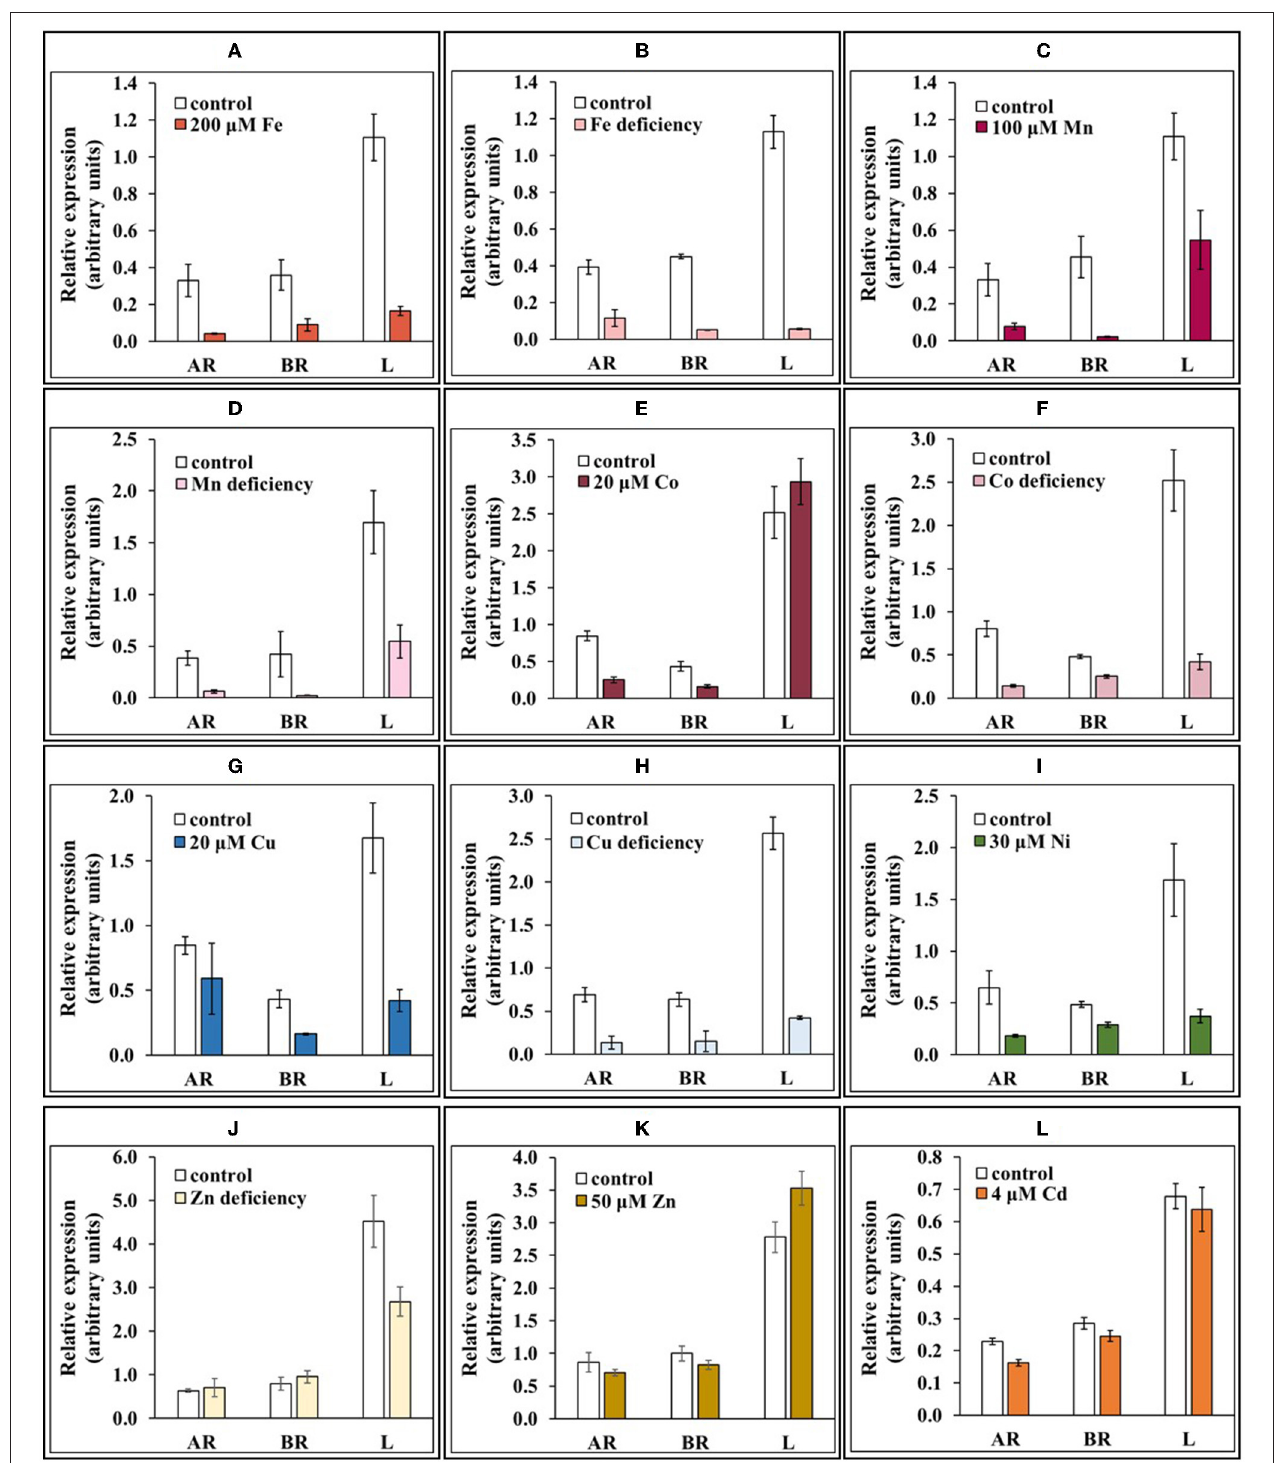
FIGURE 6 | Expression of NtNRAMP3 under different metal regimes. (A–I,L) Wild-type (WT) tobacco plants were grown at control conditions ( ¼ Knop’s medium) for 5 weeks and then were subjected to the different metal regimes for the next 4 days: (A) 200 µ M Fe; (B) Fe deficiency; (C) 100 µ M Mn; (D) Mn deficiency; (E) 20 µ M Co; (F) Co deficiency; (G) 20 µ M Cu; (H) Cu deficiency; (I) 30 µ M Ni; (J) Zn deficiency; (K) 50 µ M Zn; (L) 4 µ M Cd. In parallel, WT tobacco plants were grown at control conditions. The expression of NtNRAMP3 was determined in apical (AR) and basal (BR) segments of the roots, and in leaves (L) . NtNRAMP3 transcript level was monitored by RT-qPCR and normalized to the NtPP2A expression level. Values correspond to mean ± SD ( n ≥ 3); those with a ratio > 2 are considered significantly different (Jain et al., 2013).